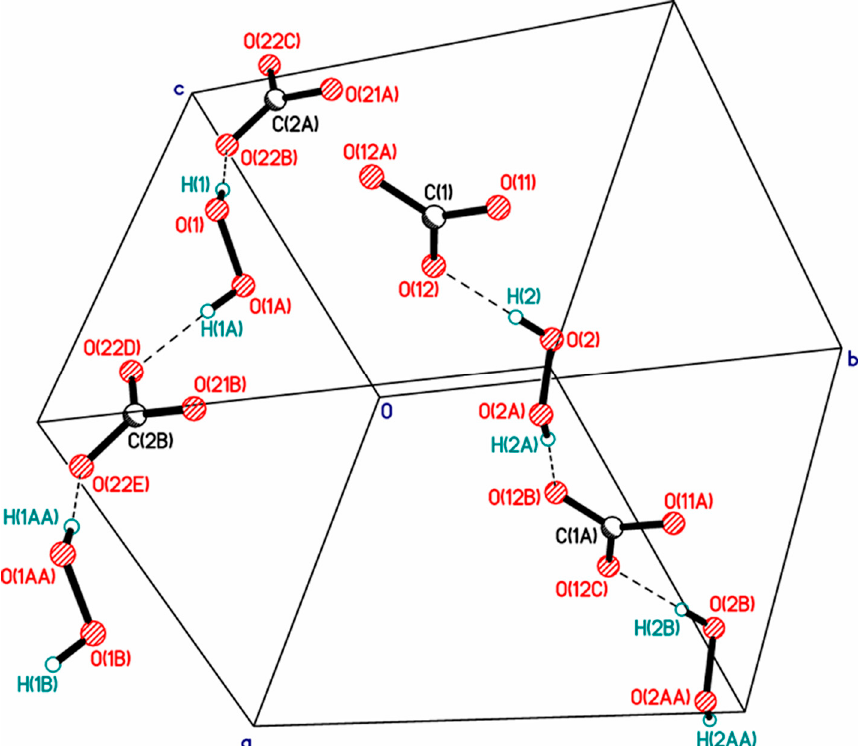
Figure 6. Fragment of the crystal structure of ammonium carbonate peroxosolvate, in which the H 2 O 2 molecule forms only two H-bonds, as a proton donor; they are given by dotted lines. Reproduced with permission from the work in [48]. Copyright 2012 International Union of Crystallography.